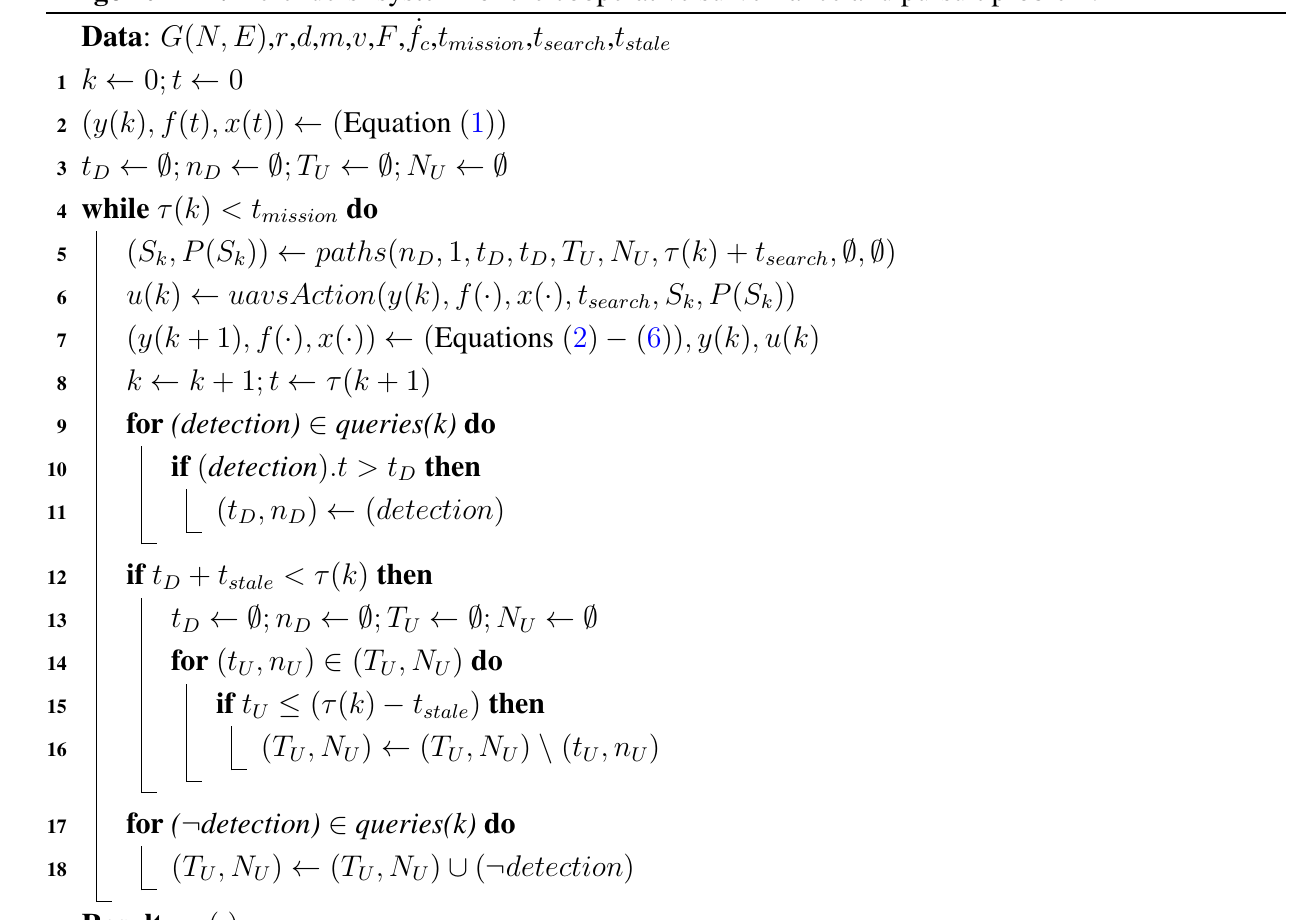
Algorithm 1: Defenders’ system for the cooperative surveillance and pursuit